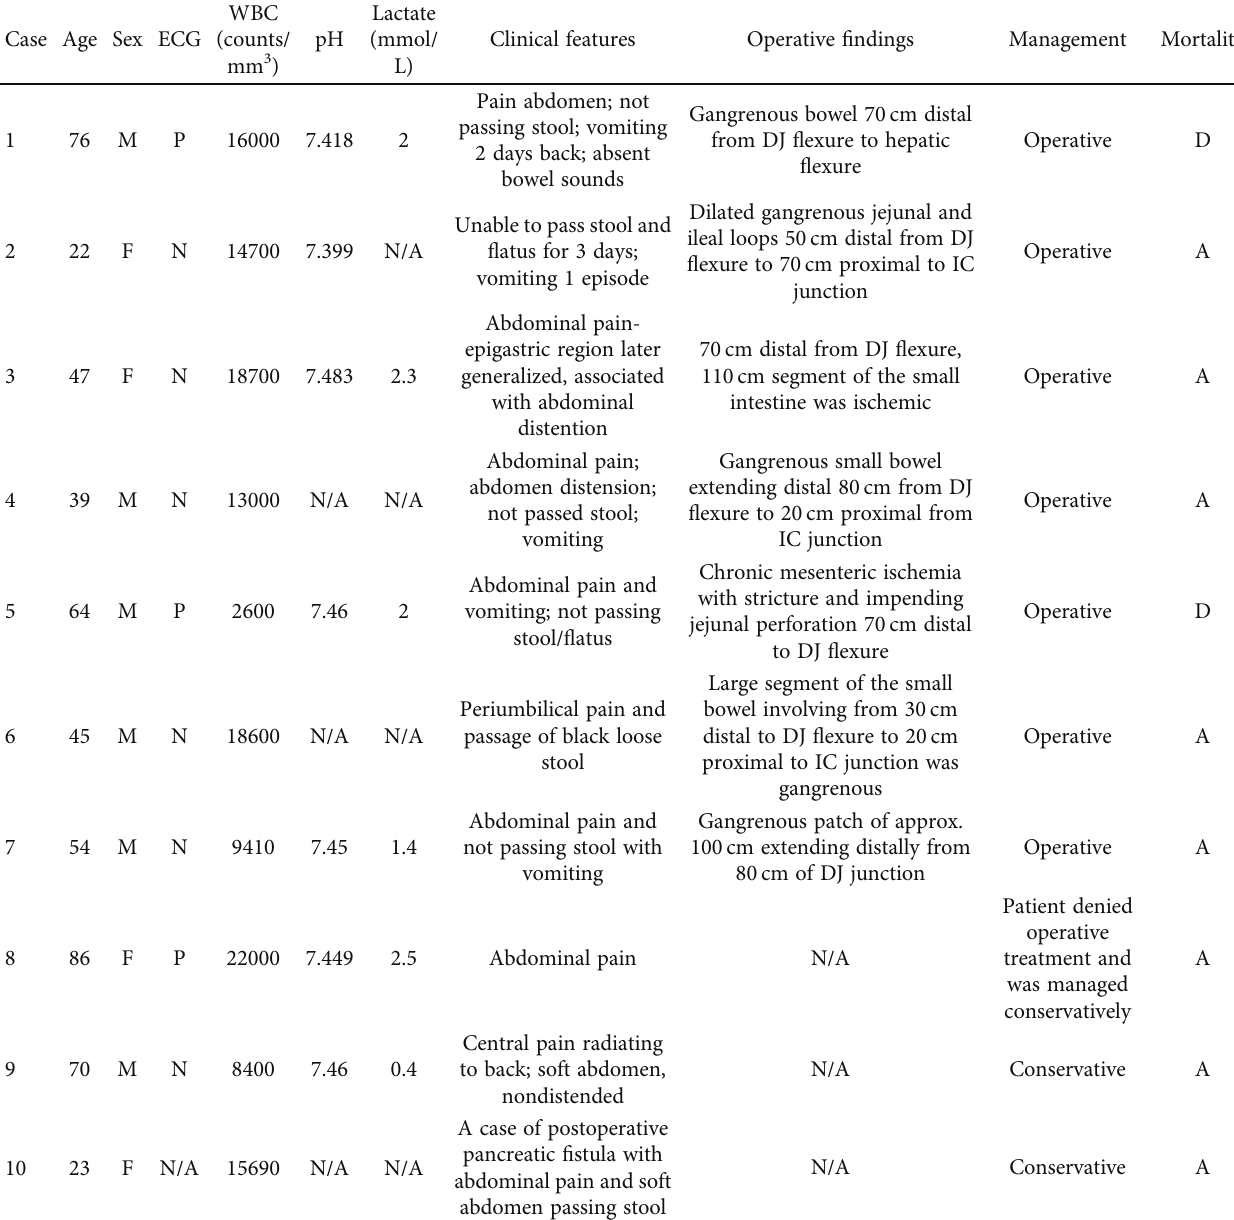
Table 2: Summary of patients ’ demography, laboratory fi ndings, treatment, and